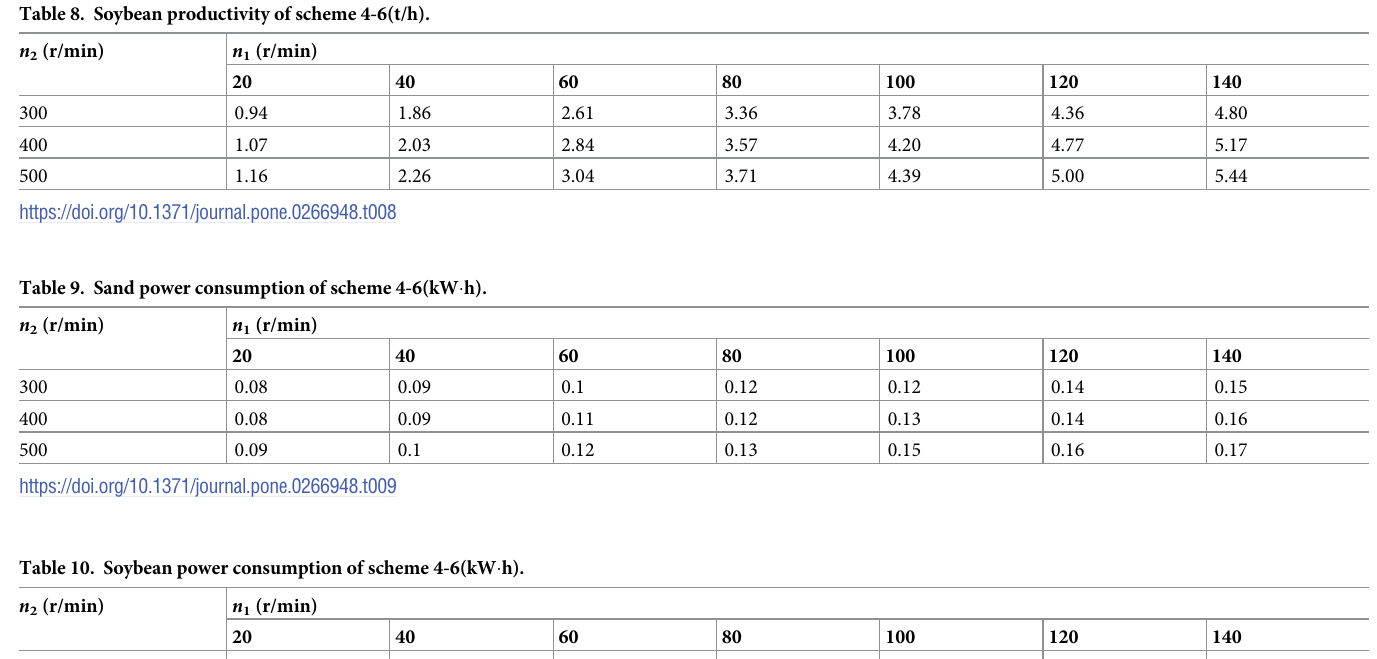
Table 10. Soybean power consumption of scheme 4-6(kW � h).